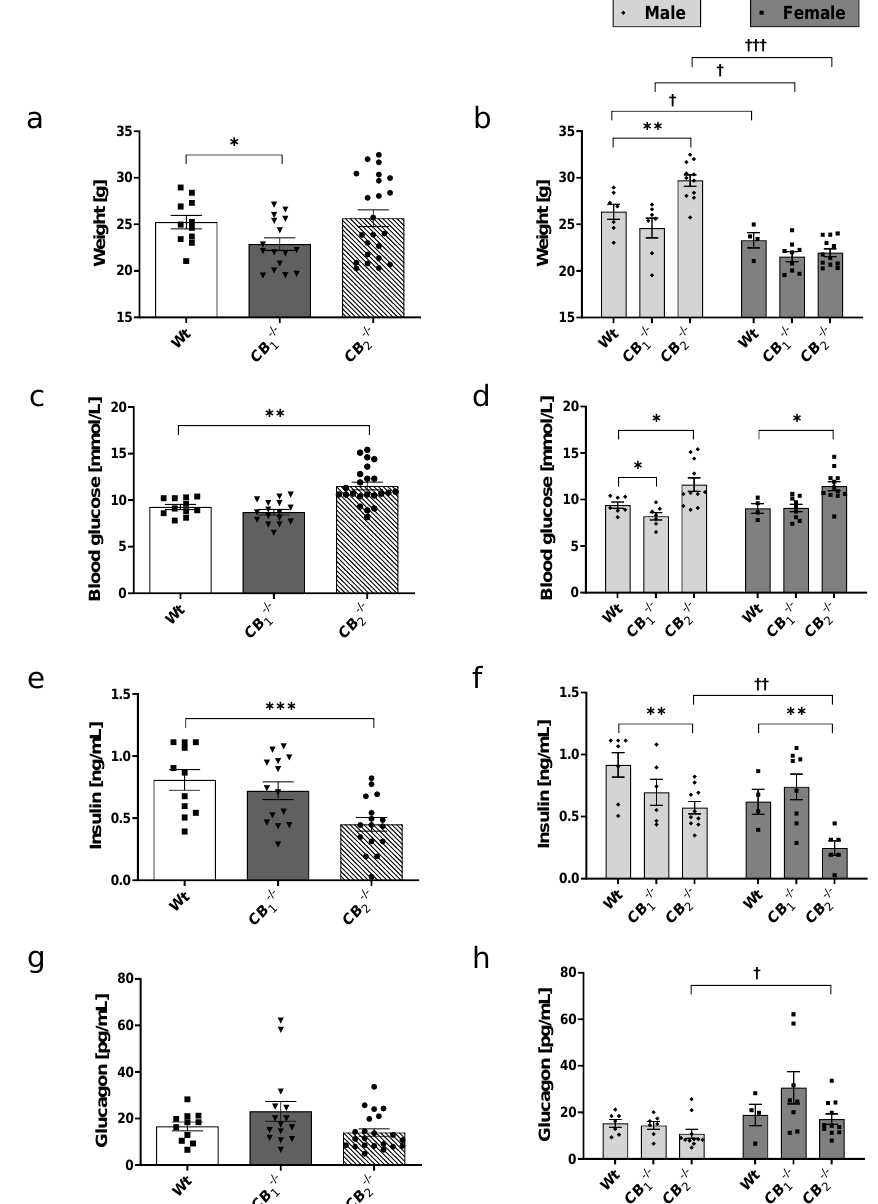
Figure 2. Determination of body weight ( a , b ), blood glucose ( c , d ), plasma insulin ( e , f ) and glucagon ( g , h ) of wild-type (Wt) and cannabinoid receptor knockout mouse lines (CB 1 − / − , CB 2 − / − ). ( a , b ) CB 1 − / − mice displayed decreased body weights. Male CB 2 − / − mice showed a significantly elevated body weight. Female mice of all groups indicated lower weights then their male counterparts. ( c , d ) Male CB 1 − / − mice showed reduced blood glucose values. In contrast, CB 2 − / − mice of both sexes revealed increased blood glucose values. ( e , f ) Mean plasma insulin levels were decreased in CB 2 − / − mice of both sexes. In addition, female CB 2 − / − mice showed lower insulin levels than male CB 2 − / − mice. ( g , h ) Mean plasma glucagon levels pointed to a slight increase in CB 1 − / − mice. Female CB 1 − / − seemed to be responsible for this increase. Female CB 1 − / − and CB 2 − / − mice showed higher glucagon levels than their respective male counterparts. Values are presented as standard error of the mean ( ± S.E.M.) with n = 11–23 animals per group or n = 4–12 animals per group when analysing data for male or female Wt and knockout mice separately. * p < 0.05; ** p < 0.01; *** p < 0.001 for overall group comparisons within male or female Wt and knockout mice; † p < 0.05; †† p < 0.01; ††† p < 0.001 for sex-specific comparisons between male and female Wt or knockout mice; unpaired t -test.